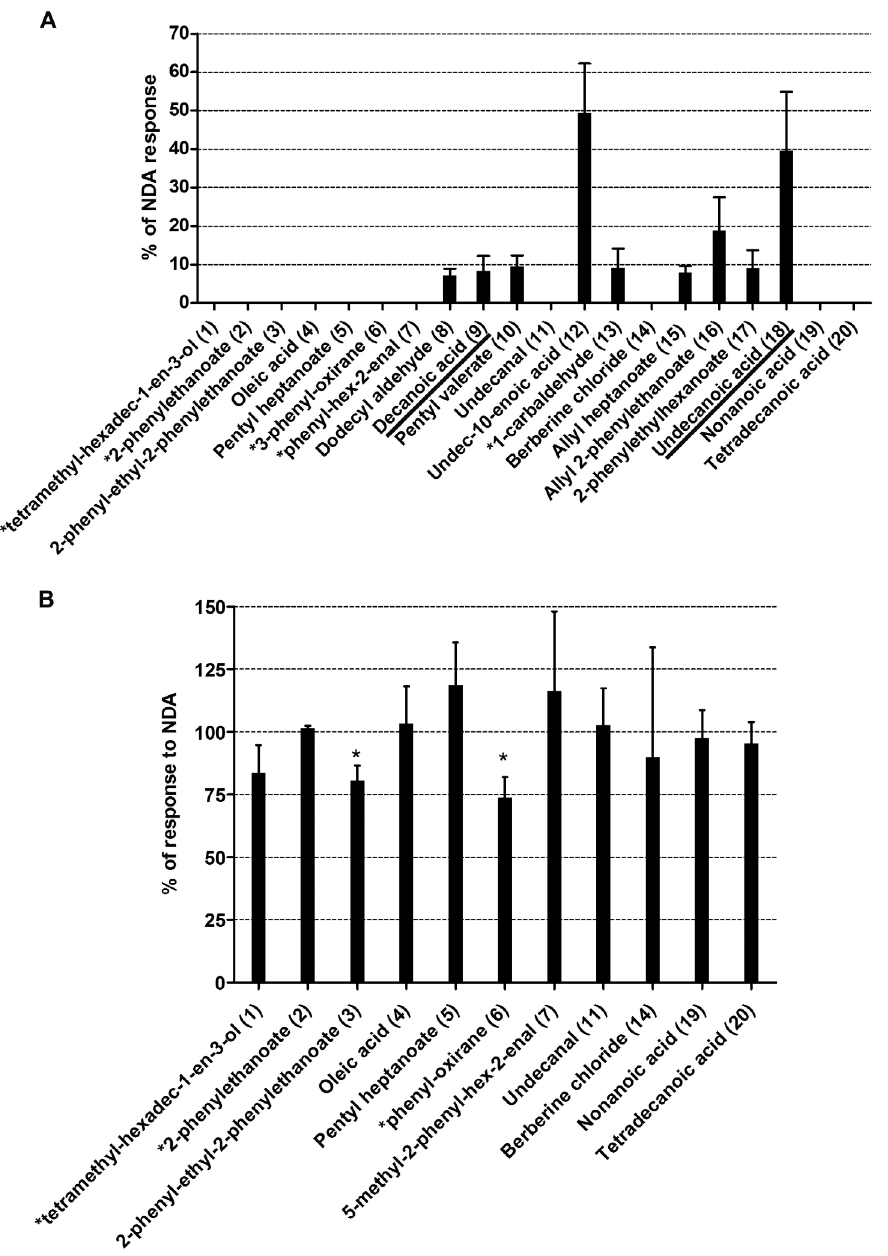
Figure 3. Invitro validation of insilico results. A. Histogram showing relative activity of the top 20 candidate ligands listed according to their mfscore, tested at 100 m M and normalized to the nonanedioic acid, mean 6 SEM, n=5–10. Full name of the compounds: Compound 1=3,7,11,15- tetramethyl-hexadec-1-en-3-ol (1); Compound 2=1-methyl-ethyl-2-phenylethanoate (2); Compound 6= ethyl-3-methyl-3-phenyl-oxirane-2- carboylate (6); compound 7=5-methyl-2-phenyl-hex-2-enal (7) and compound 13=4-(4-hydroxy-4-methylpentyl)-cyclohexene-1-carbaldehyde (13). B. Histogram showing response of ligands tested as antagonists at 1mM concentration, in the presence of 10 m M NDA. Compounds 3 and 6 were identified as low potency antagonists, *p , 0.0025. Previously identified ligands for MOR42-3 confirmed in our in silico screen are underlined. doi:10.1371/journal.pone.0092064.g003 134.5 6 34.8, n =7 and 89.9 6 43.8, n = 8, respectively, results not shown). Decanedioic and dodecanoic acid, previously identi- fied as MOR42-3 agonists were not ranked in either top 20 list; decanoic acid was ranked at 367 in the VLS, with a score of 2 14.47 and an mfScore of 2 62.40 and dodecanoic acid ranked at 499 in VLS with score of 2 10.45 and an mfScore of 2 79.91 (see Table S1 ).